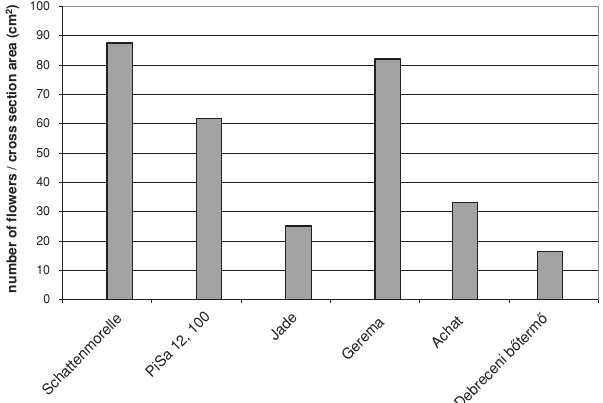
Figure 5. Specific number (related to cross section area) of flowers produced by sour cherry varieties ( Debrecen-Pallag, 2010)